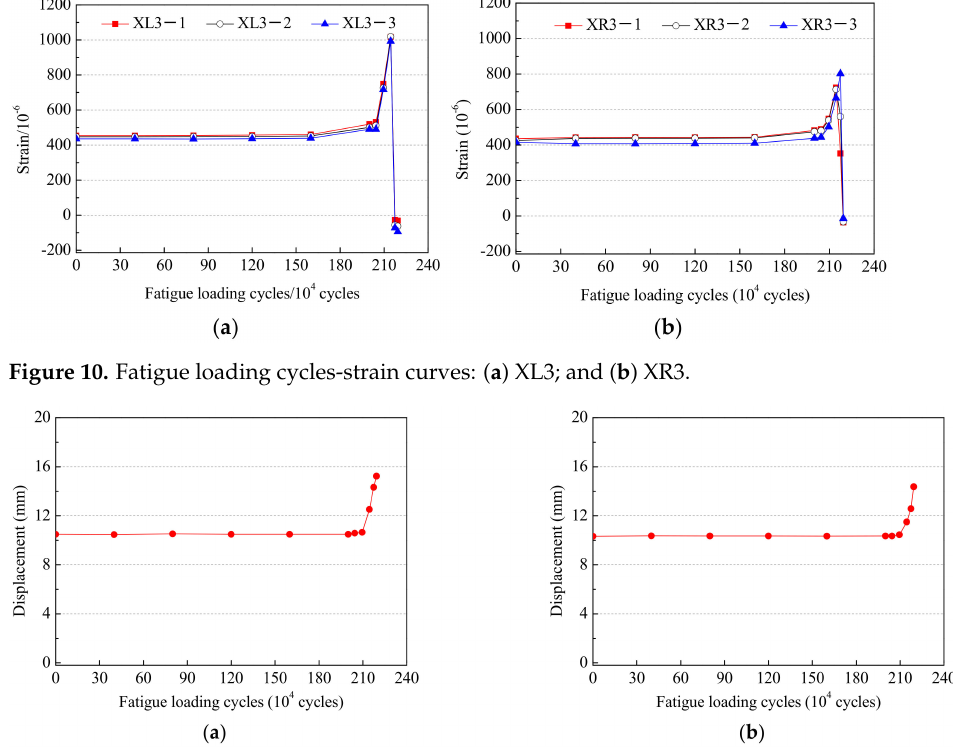
Figure 11. Fatigue loading cycles-displacement curves: ( a ) WL2; and ( b )